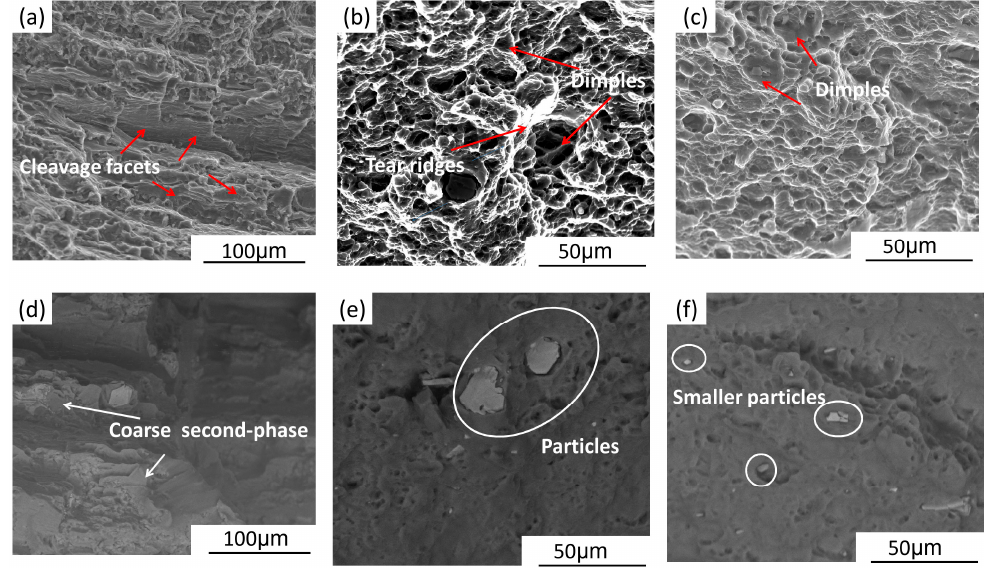
Figure 9. Surface characteristics of the fractured specimens after tensile tests of ( a , d ) BM; ( b , e ) one-pass SFSP; ( c , f ) two-pass SFSP specimens.